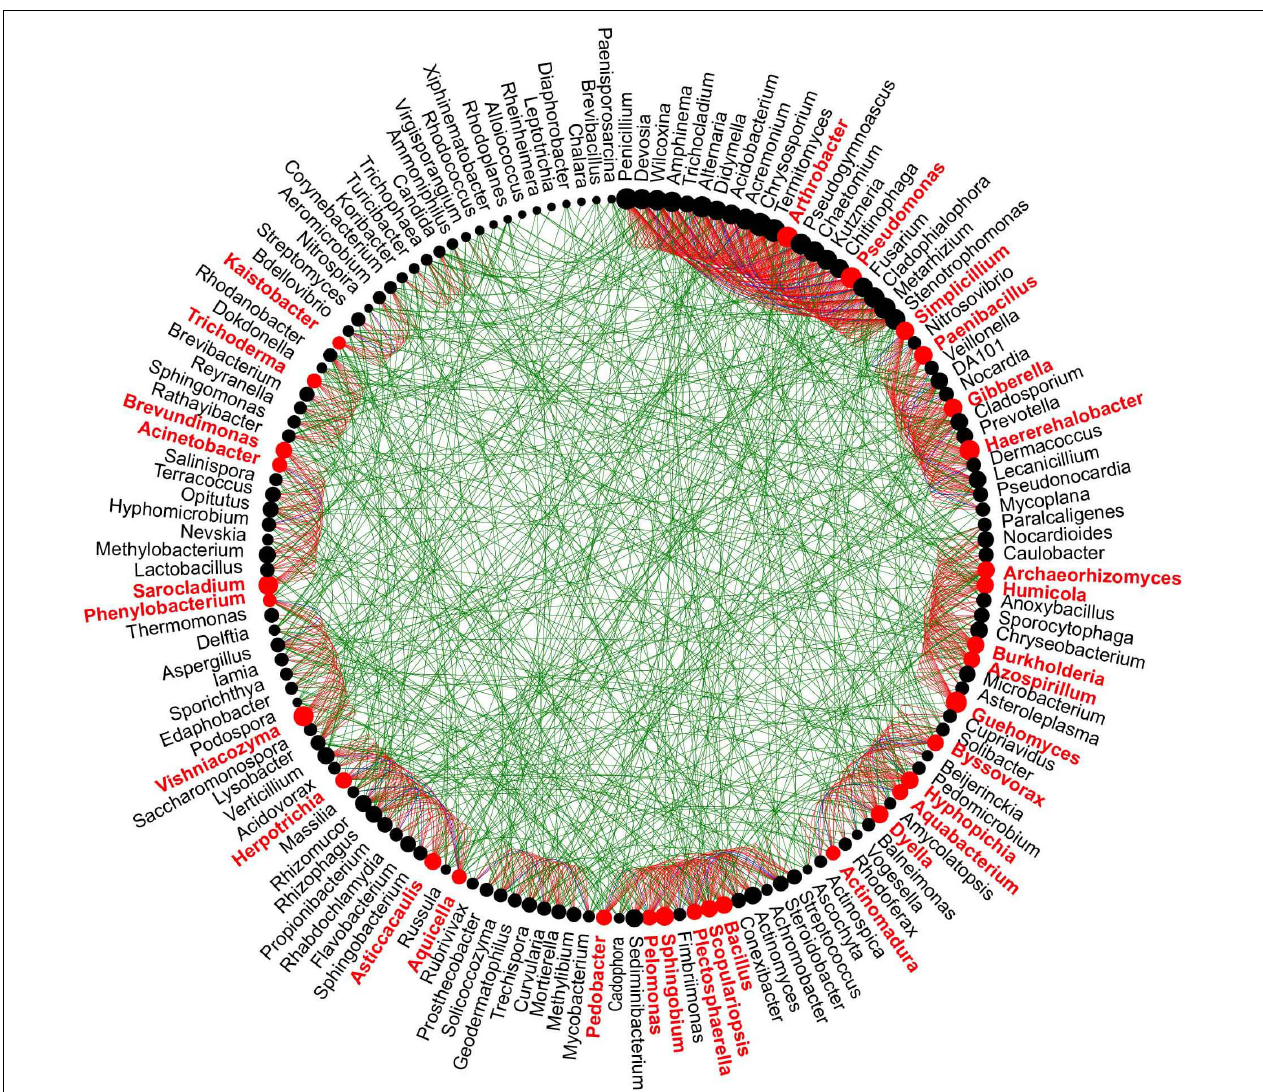
FIGURE 5 | Potential “driver taxa” in the soil obtained from 2-year-old AG plants as determined in microbial co-occurrence networks between soils obtained from healthy and diseased AG plants. Node sizes are proportional to their scaled NESH (neighbor shift) score (a score identifying important microbial taxa of microbial association networks), and a node is colored red if its betweenness increases when comparing soil microbiomes associated with healthy and diseased plants. As a result, large red nodes denote particularly important driver taxa, and these taxa names are shown in red color. Green edges: association present only in healthy ginseng microbiomes; red edges: association present only in diseased plant microbiomes; blue edges: association present in both healthy and diseased plant